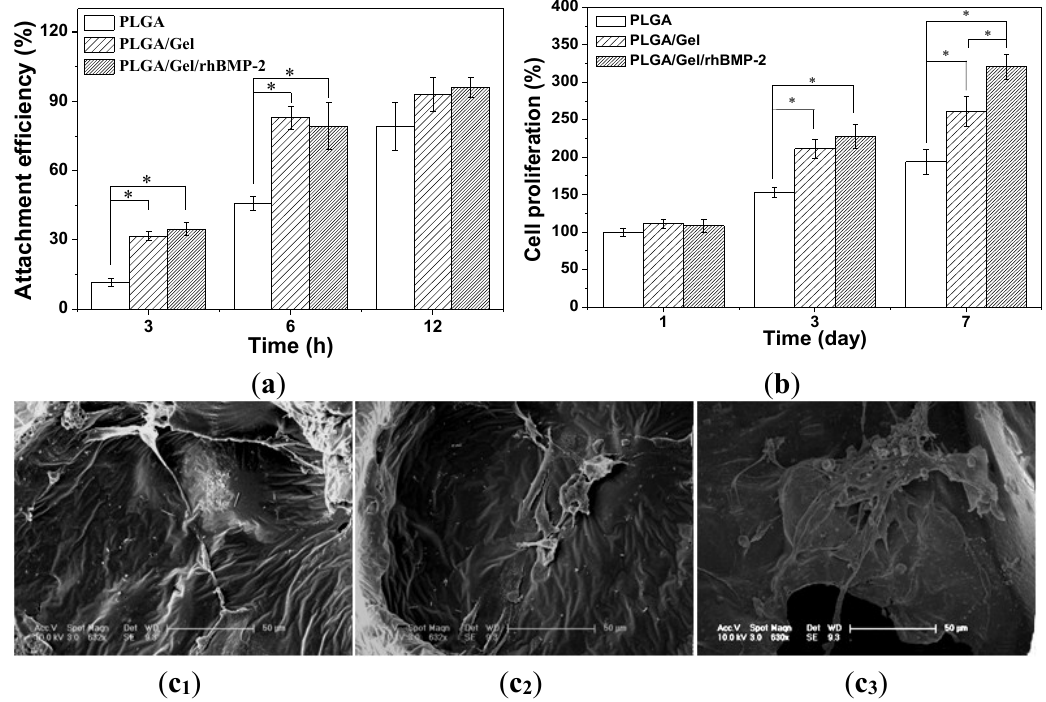
Figure 8. In vitro growth of BMSCs in scaffolds. Cell attachment efficiency on PLGA, PLGA/Gel, and PLGA/Gel/rhBMP-2 scaffolds at 3 and 6 h ( a ); Cell proliferation on PLGA, PLGA/Gel, and PLGA/Gel/rhBMP-2 on Day 1, 3, and 7 ( b ); and SEM microimages of cell attachment on PLGA ( c ), PLGA/Gel ( c ), and PLGA/Gel/rhBMP-2 ( c ) on Day 7 ( c 1 2 3